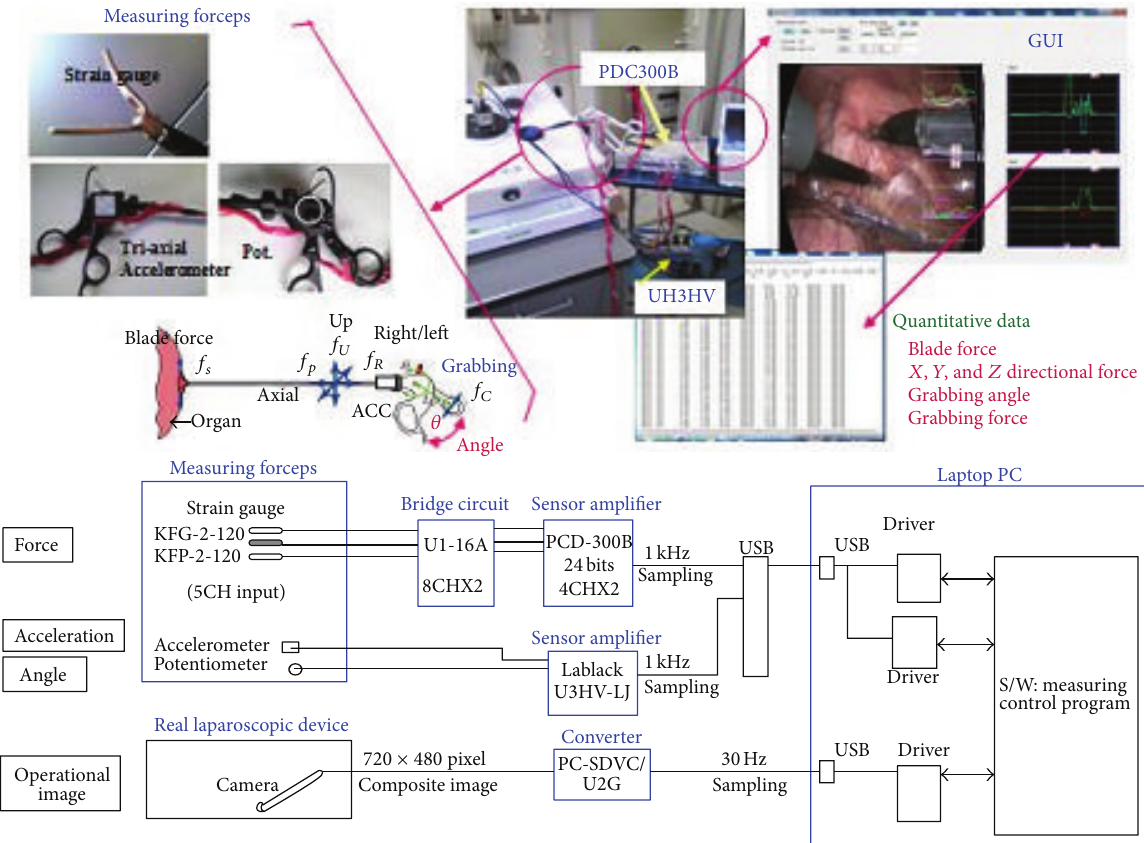
Figure 3: The system we developed to detect the sensation of the forceps.